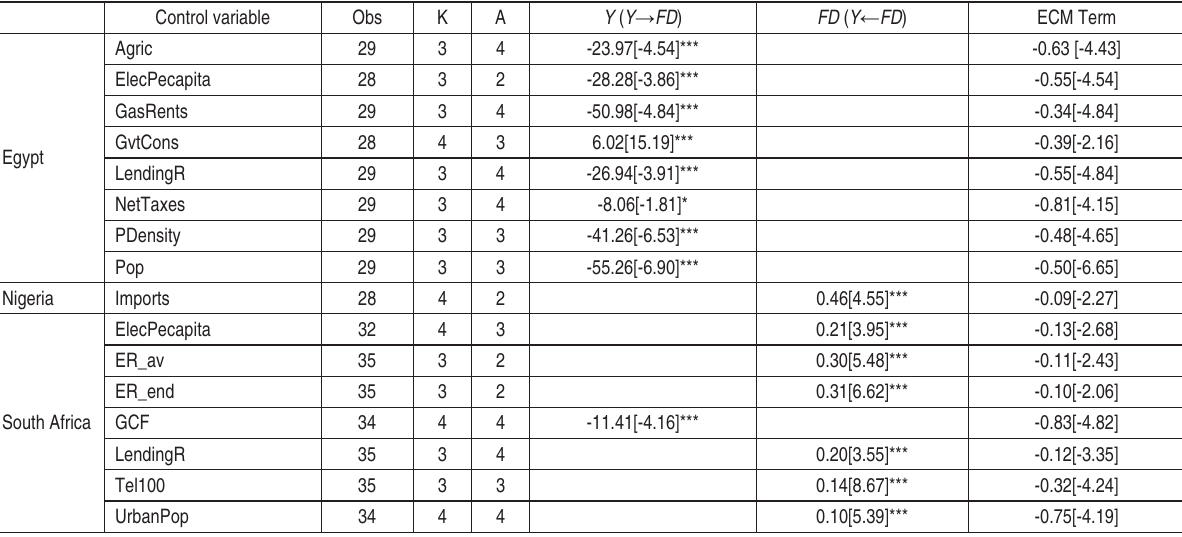
Table 2. Long run parameters: S-Activity and per capita GDP